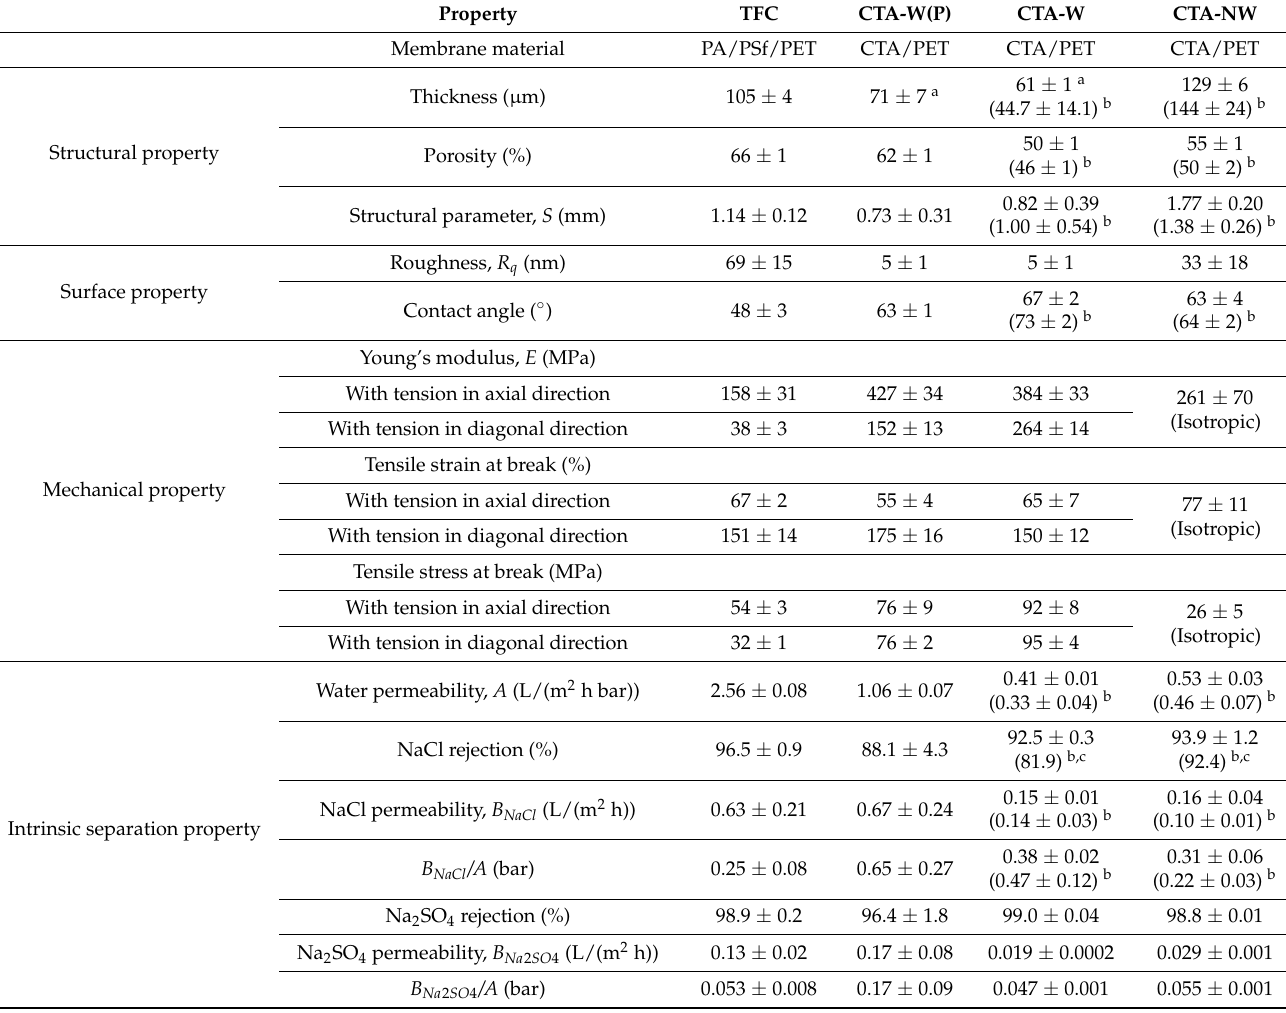
Table 1. The chemical property, structural property, and intrinsic separation property of